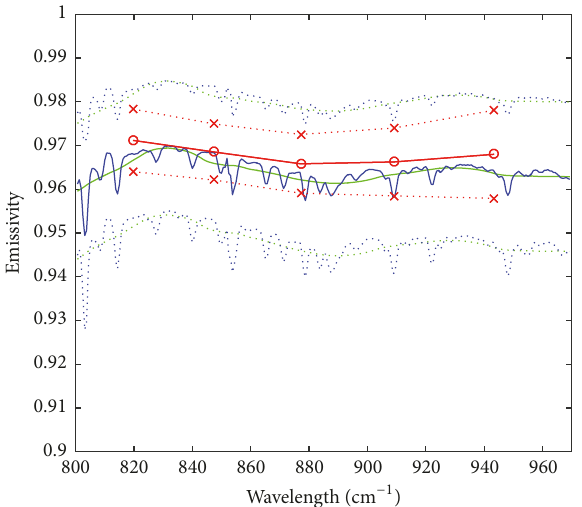
Figure 5: An overview of the LSE retrievals in May with the ARIS LSE product. The solid red line indicates the mean ARIS LSEs, and the dotted red lines show the standard deviation of the mean LSEs. Similarly, the blue lines are the mean and standard deviation of the original CrIS LSEs, while the green ones are for the smoothed CrIS